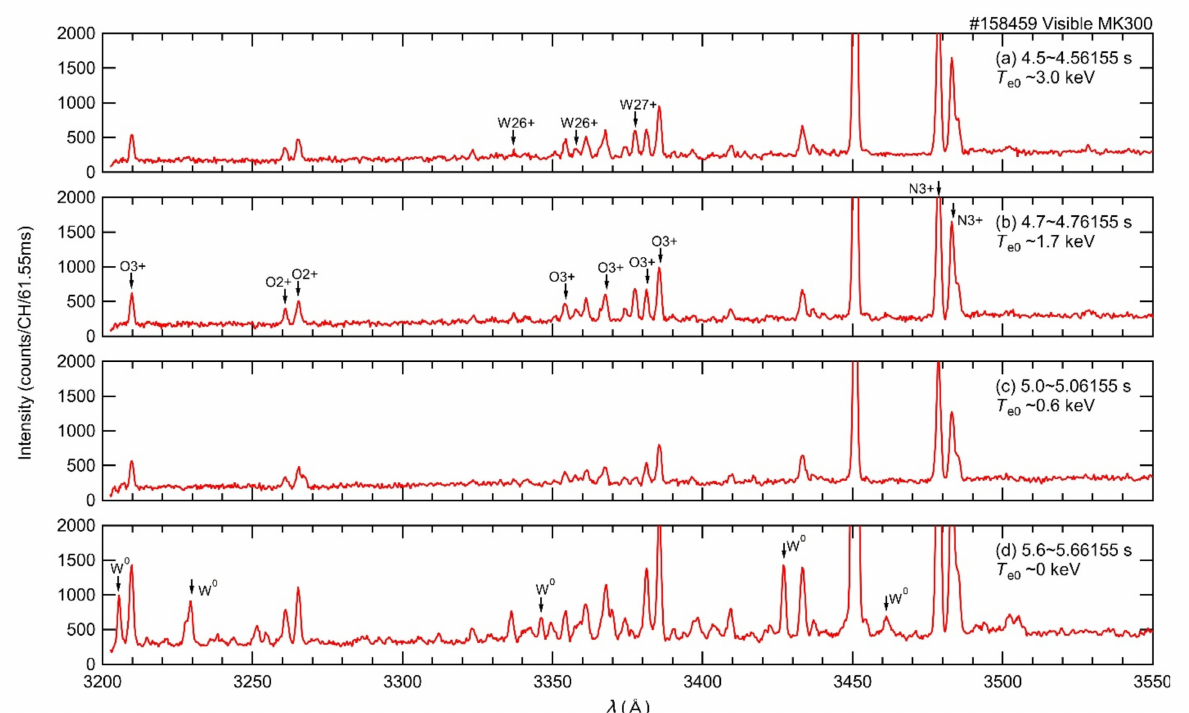
Figure 4. Visible spectra including W 0 , W 26+ , and W 27+ line emissions in the wavelength range of 3200–3550 Å measured using “MK300” spectrometer. Central electron temperature, T e 0 , is also indicated for each timing of data acquisition.